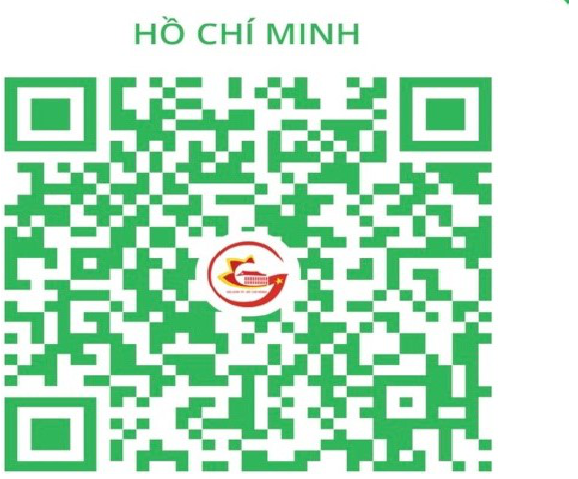
Figure 4. PC COVID: quick response